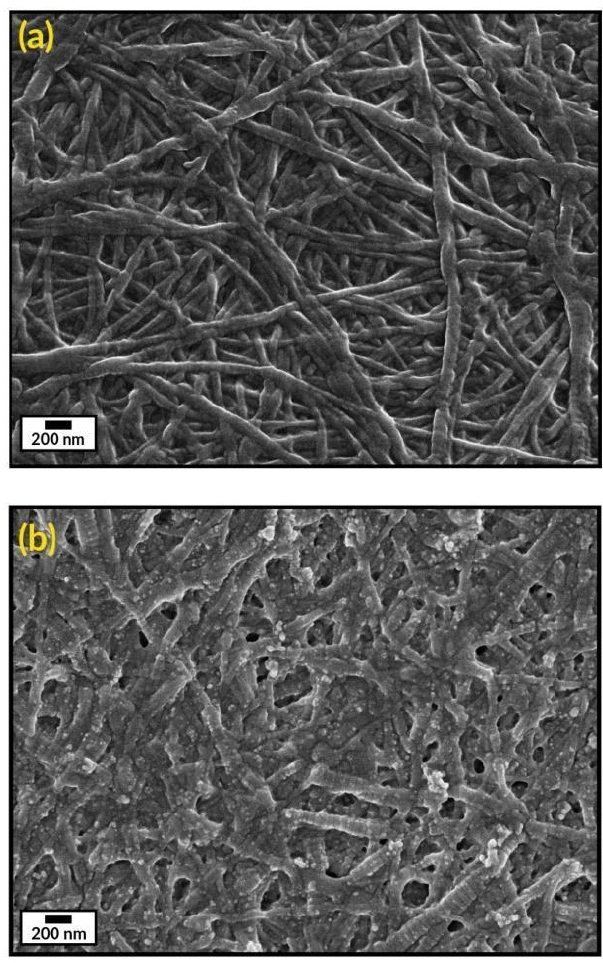
Figure 4. SEM images of ( a ) collagen hydrogel (Col) and ( b ) collagen gel containing silver nanoparticles (Col-AgNPs). Scale bars represent 200 nm.